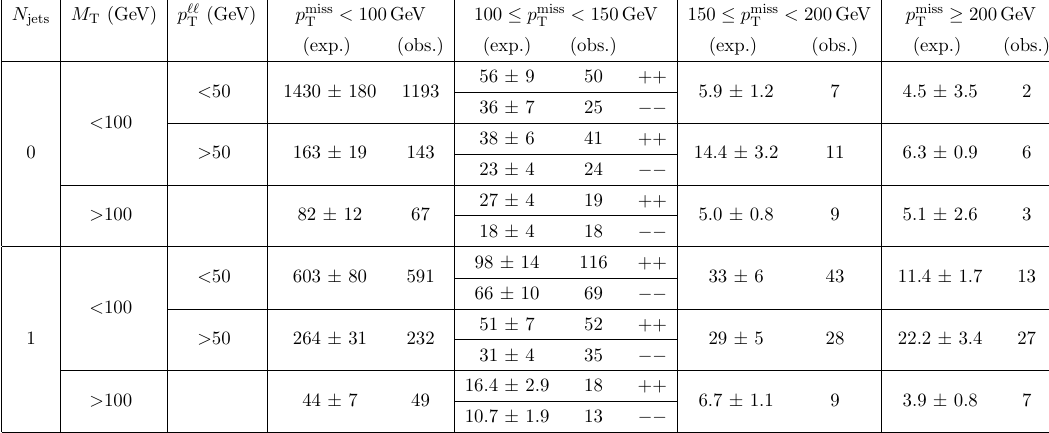
Table 11 . SS dilepton category: expected and observed yields in events with two SS light-(cid:13)avor leptons. For each bin, the (cid:12)rst number corresponds to the expected yield (exp.) and its uncertainty, and the second denotes the observed yield (obs.). The uncertainty denotes the total uncertainty in the